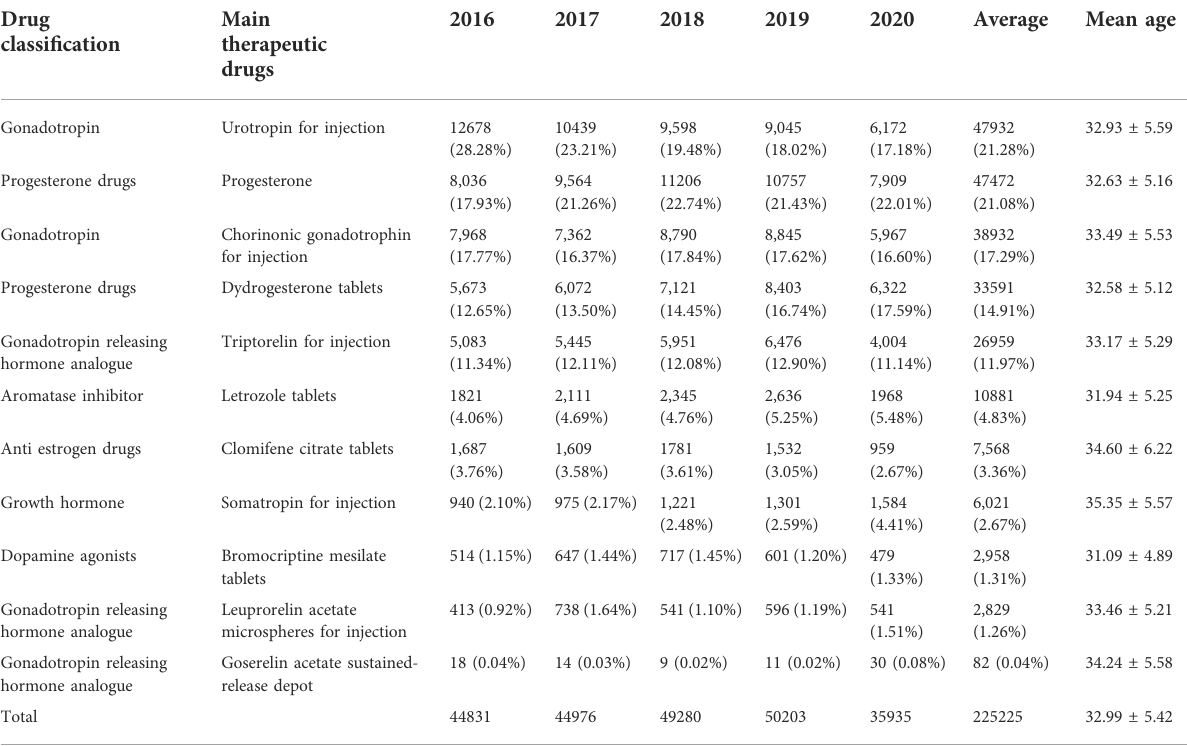
TABLE 2 Main therapeutic drugs of the patients ( n =